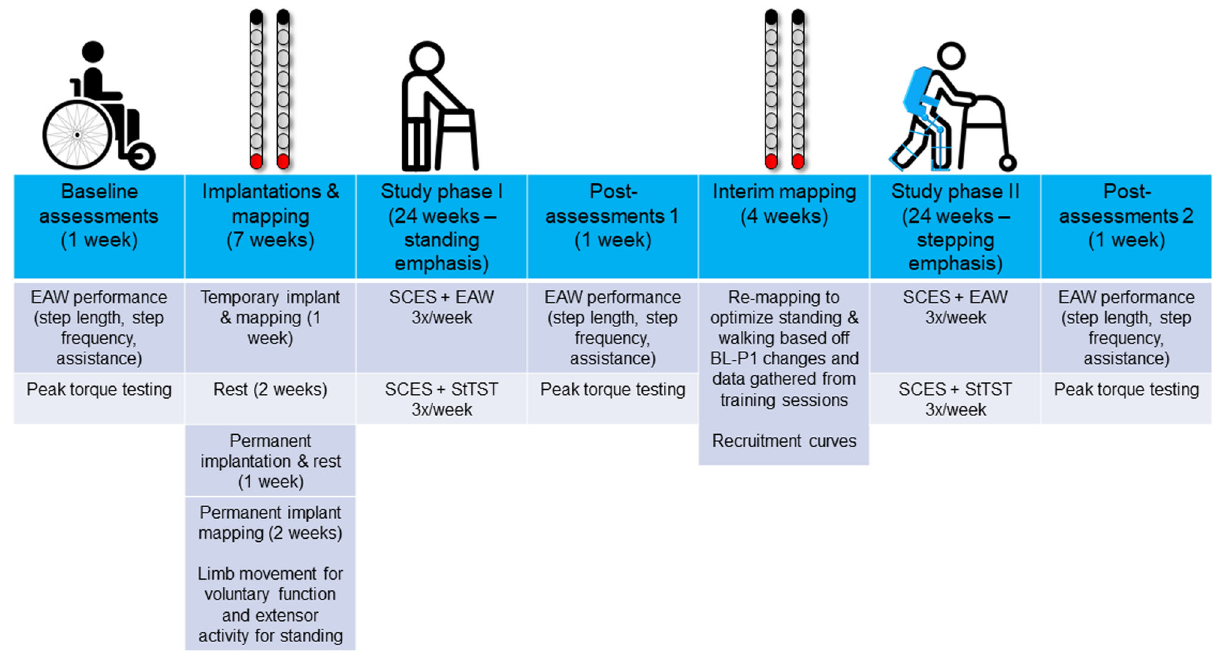
Fig. 1 | Study timeline. Timeline of study phases for NCT04782947. After baseline outcomemeasuresareassessed,temporaryimplantationoccursfollowedby5days ofmapping.Afterremovalofthetemporaryimplant,participantsaregiven2weeks rest and then receive the permanent implant. Permanent implant mapping occurs for 2 weeks, focusing mainly on voluntary limb movement and extensor activity to facilitate standing. Following this, phase I of the study begins, consisting of 24weeks training 3 days perweek. Each training day consists ofone hour of spinal